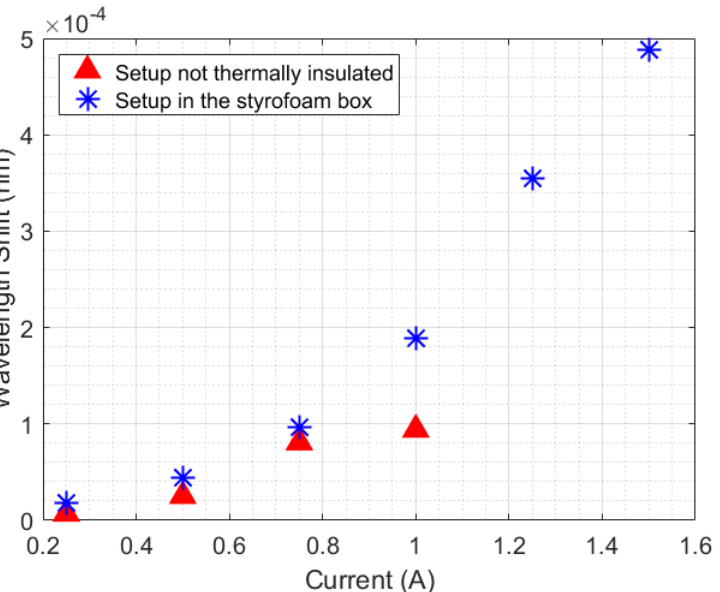
Figure 5. Comparison of the thermal distribution behavior in the experiment with the beaker (with and without thermal